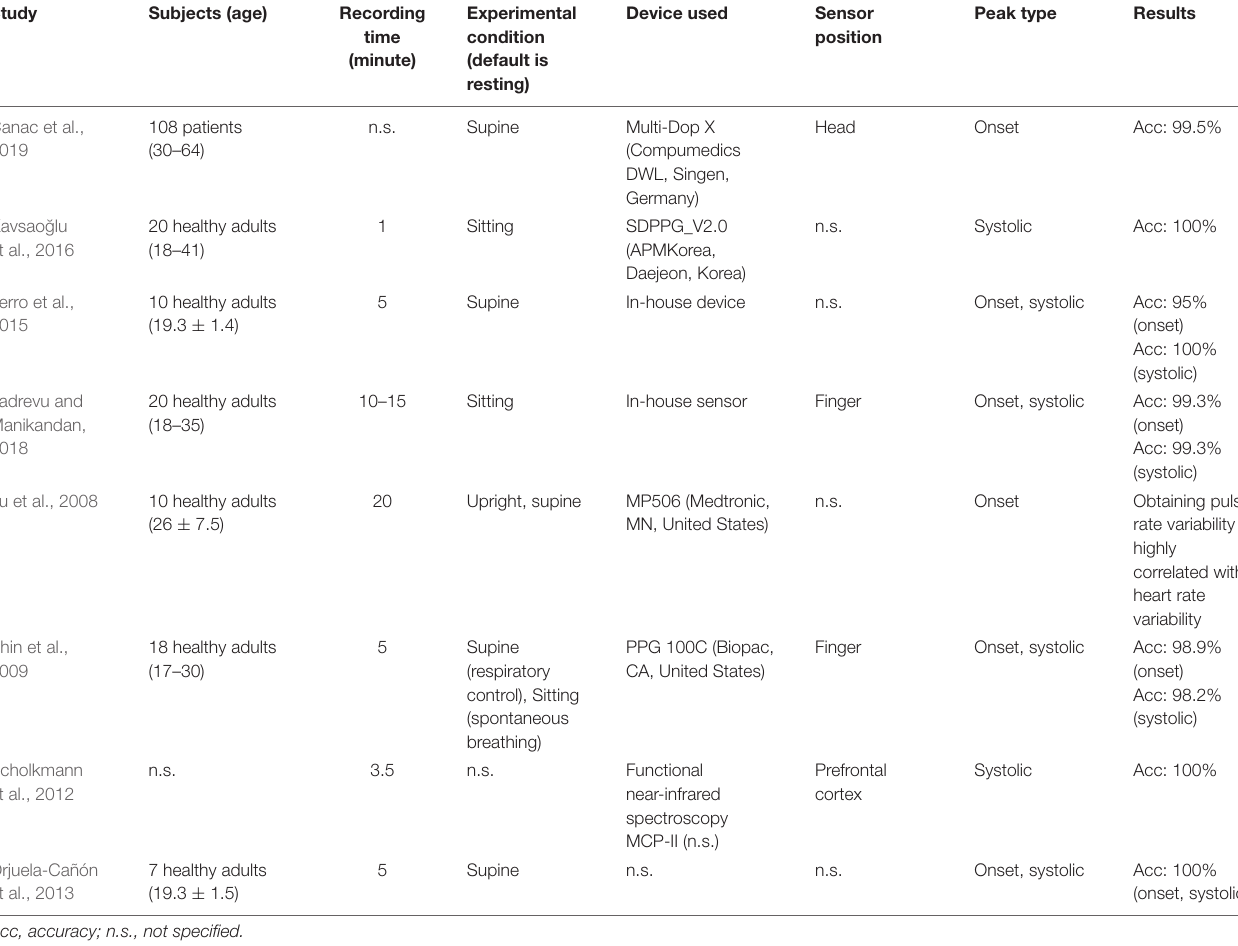
TABLE 3 | Overview of studies on peak detection of PPG.